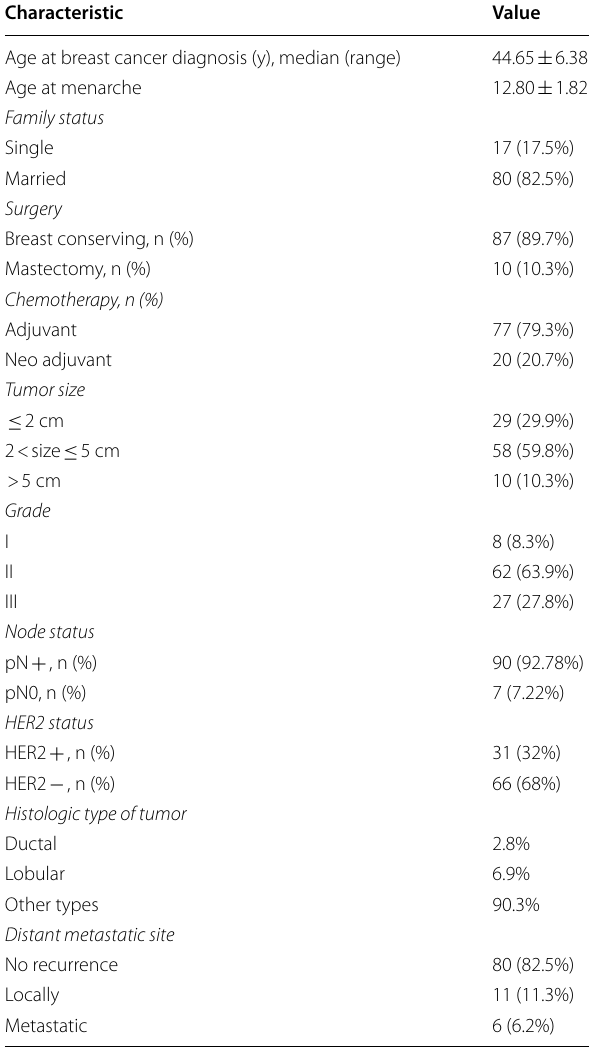
Table 1 Relevant Clinico-pathological features of the